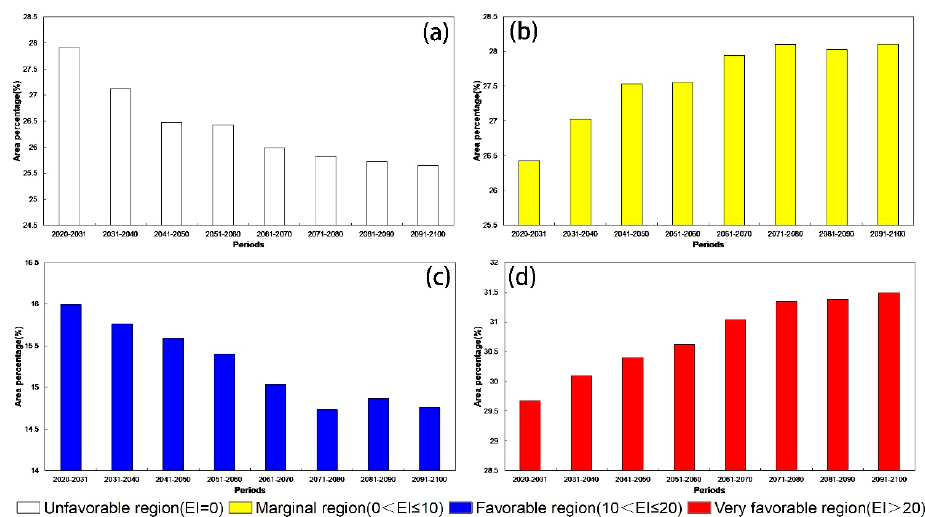
Figure 5. The proportion of climate-suitable global areas in future decades (2021–2030, 2031–2040, 2041–2050, 2051–2060, 2061–2070, 2071–2080, 2081–2090, and 2091–2100). ( a – d ) represents proportion of changes in unfavorable, marginal, favorable, and very favorable regions, respectively.